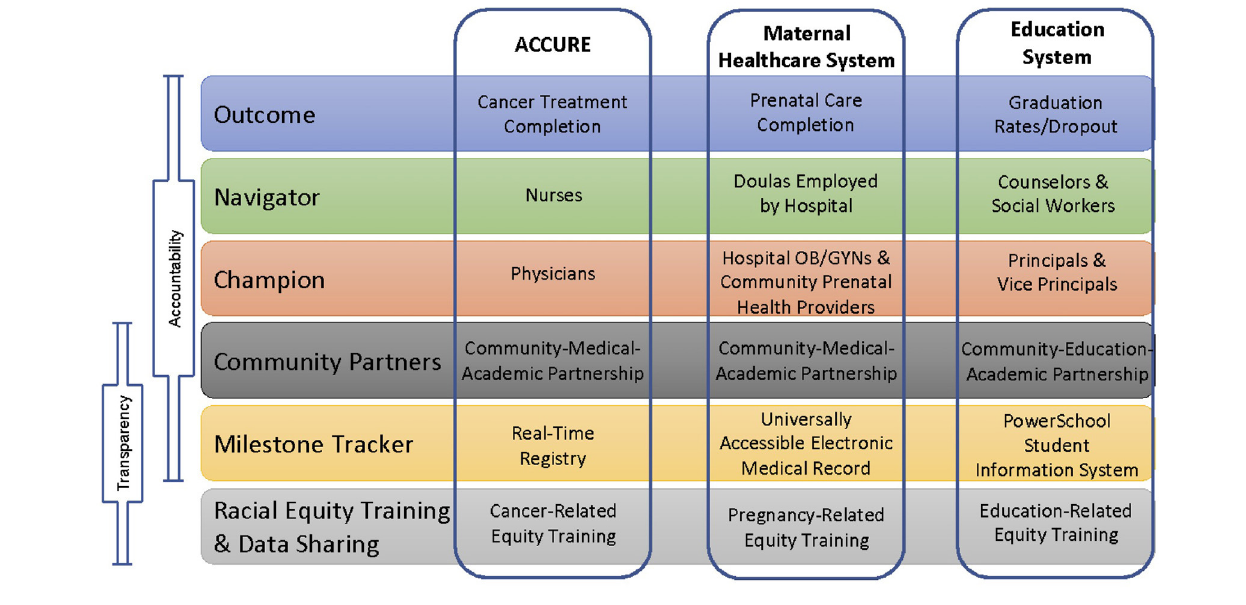
FIGURE 2 | Core components of ACCURE and representative examples in the maternal healthcare and education